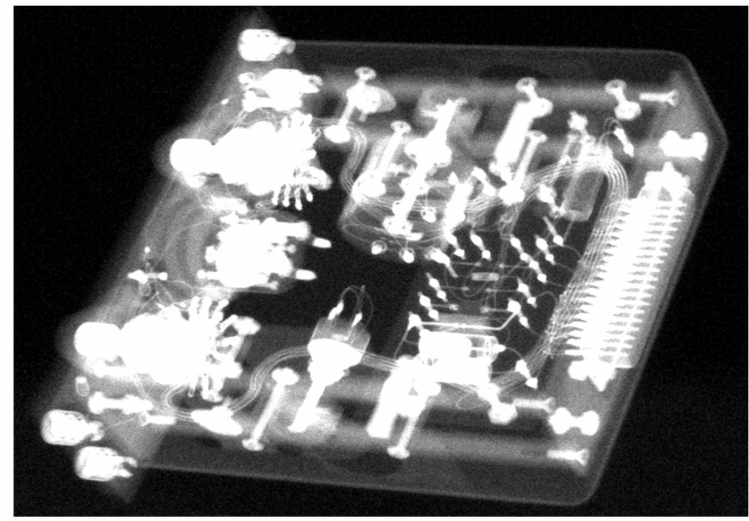
Figure 9. X-ray projection image with simulated and added Poisson noise.